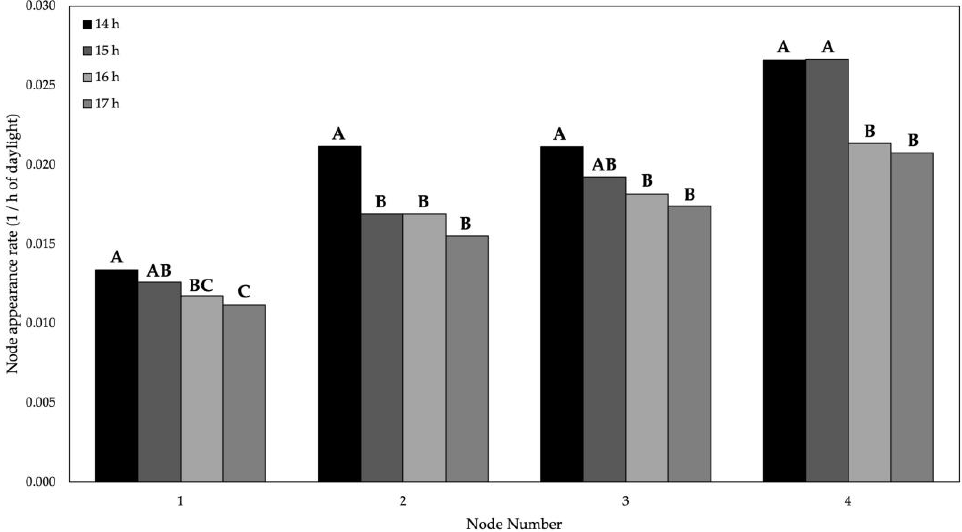
Figure 2. Node appearance rate (NdAR) for nodes 2, 3, 4, and 5 in 14-, 15-, 16-, and 17-h photoperiods. Bars followed by the same letter are not significantly different at p < 0.05 according to Tukey’s HSD test for a node.